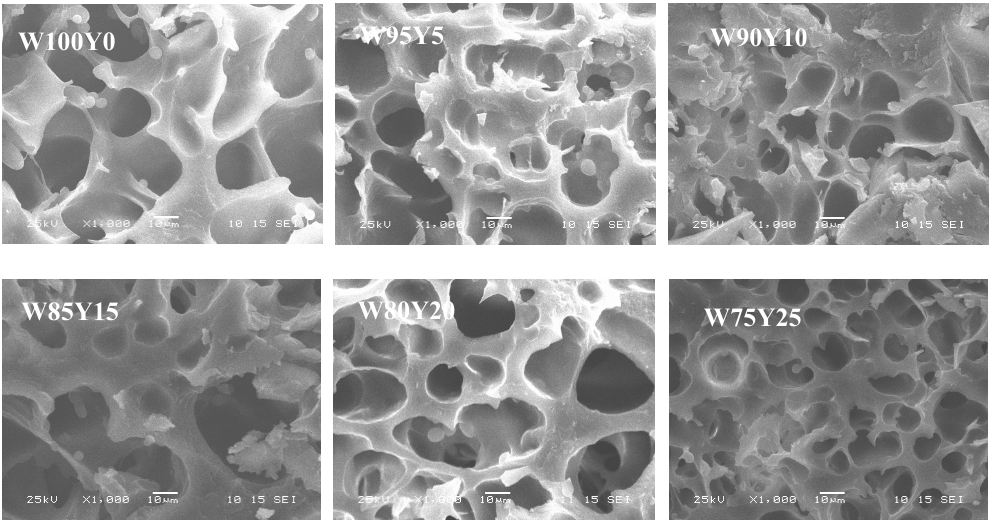
Figure 5. SEM images of gluten substituted with different level of yam flour. The magnifications of SEM images were 1000×.